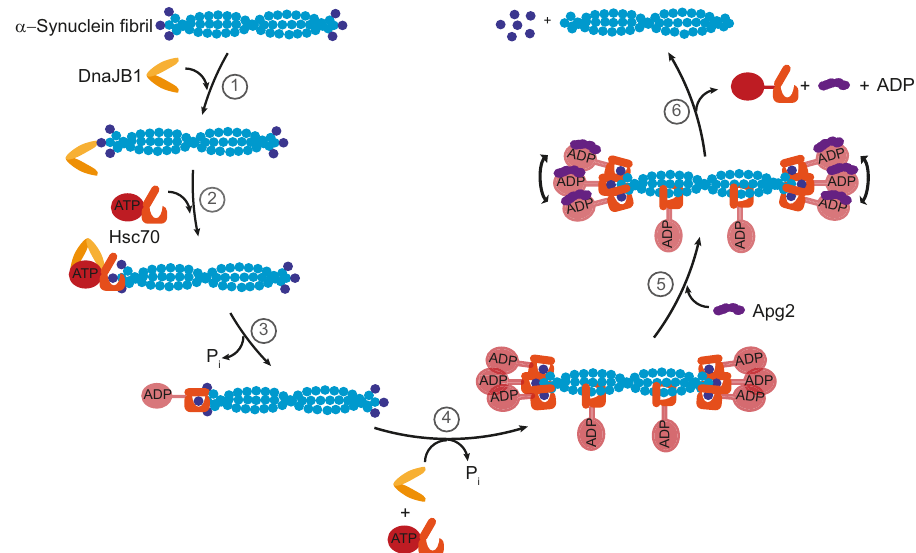
Fig. 6 Emerging principles of Hsc70 disaggregase activity. Model for Hsc70-mediated protein disaggregation of α S fi brils. This disaggregation mechanism comprises six steps: step 1, DnaJB1 binding to α S fi brils; step 2, Hsc70 loading onto fi brils mediated by DnaJB1; step 3, hydrolysis of Hsc70- bound ATP to ADP and dissociation of DNAJB1; step 4: further Hsc70 loading resulting in clustering of Hsc70 at fi bril ends; step 5, Apg2 binding to Hsc70; step 6, dissociation of α S monomer coupled to ADP dissociation from Hsc70 and disassembly of the chaperone